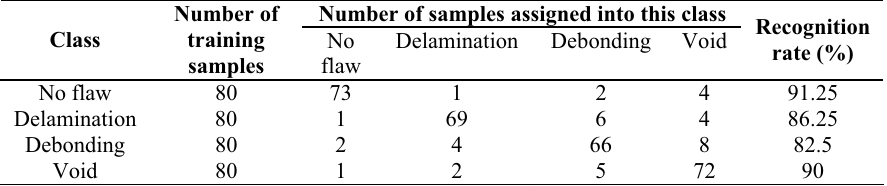
Table 7. Classification result using DWT_PCA based